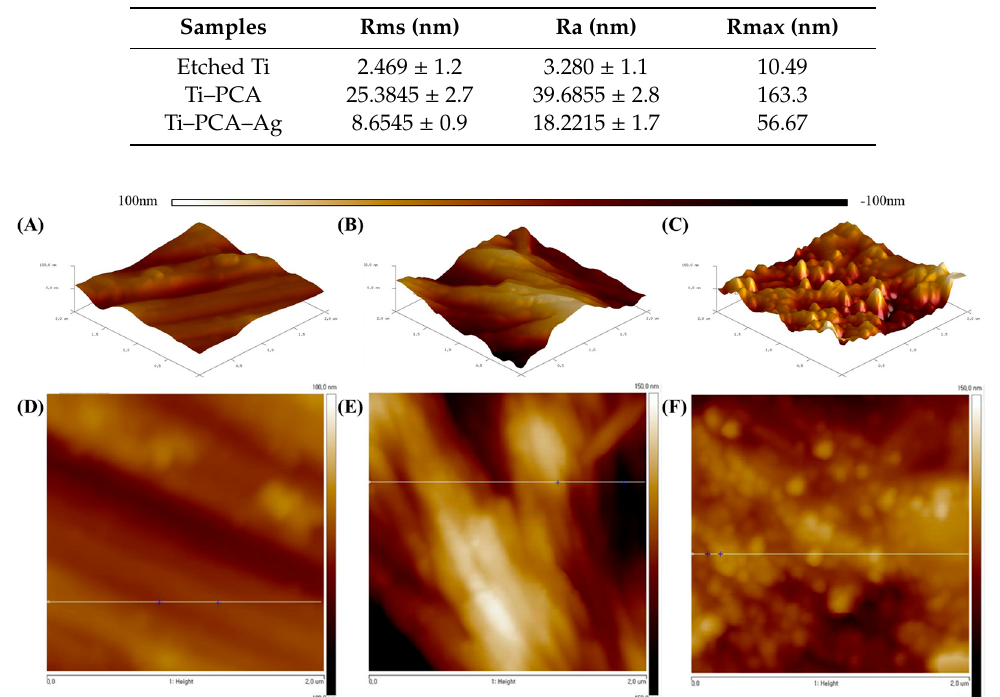
Figure 2. 3D and 2D surface AFM images (2 µ m × 2 µ m) and lateral profiles of each surface: ( A , D ) Etched Ti, ( B , E ) Ti–PCA, and ( C , F ) Ti–PCA–Ag.